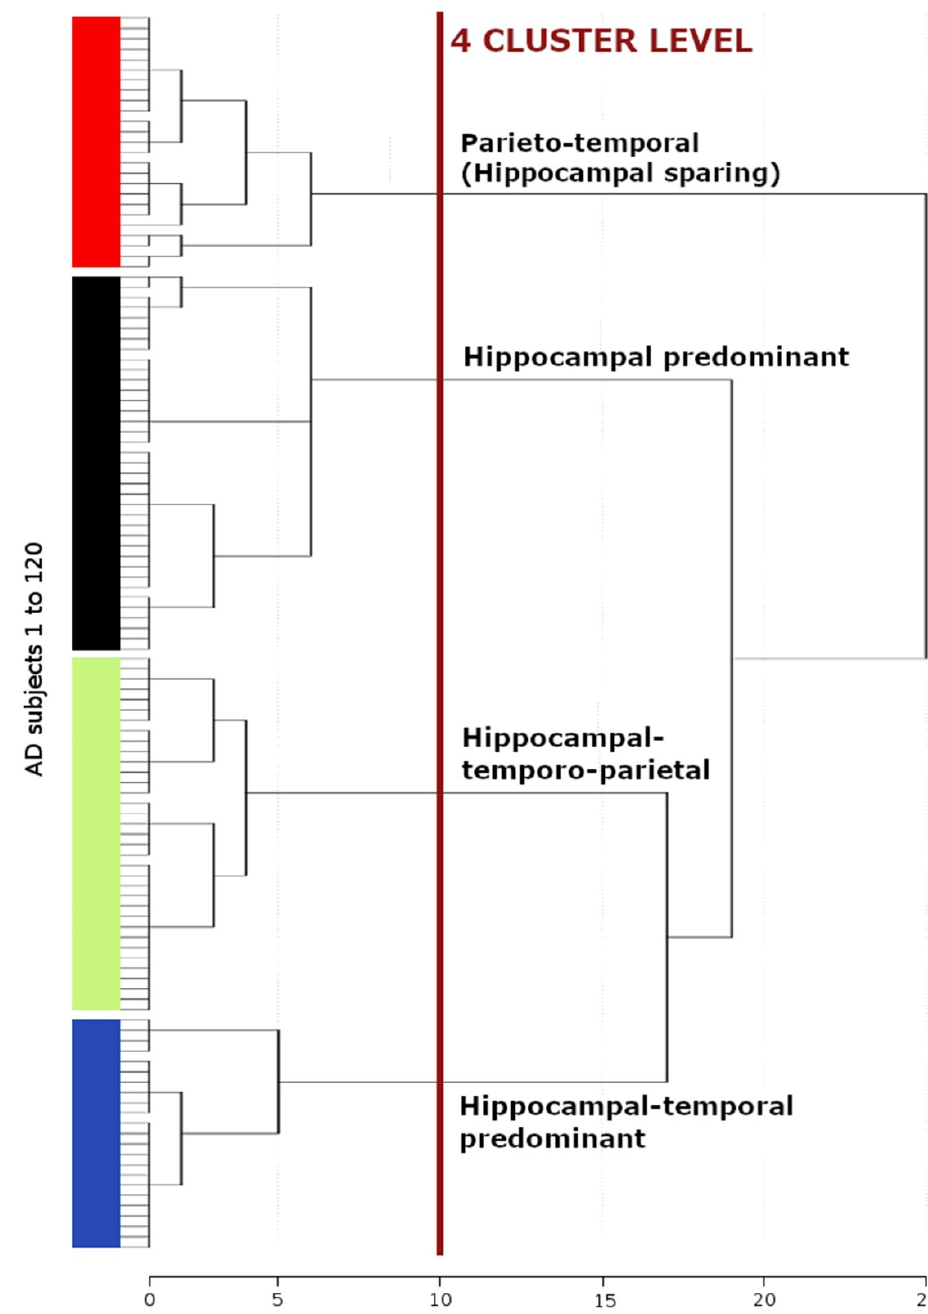
Figure 2. Hierarchical clustering dendrogram of morphometric Alzheimer’s disease subtypes. Ward’s linkage method was used to progressively cluster individual cases together. The distance along the x -axis represents the measure of similarity between patients, such that the longer the distance the greater the dissimilarity between the subjects, while the different colors of the vertical bar correspond to different Alzheimer’s disease subtypes. The red line reveals the clustered subtypes of AD dementia, which are illustrated in Figure